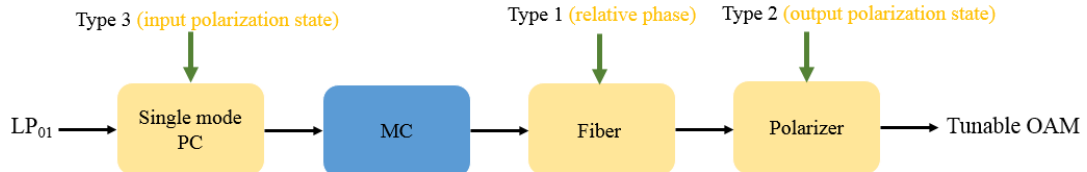
Figure 9. A typical experimental setup based on fiber to generate tunable OAM modes. PC: polarization controller, MC: mode converter.